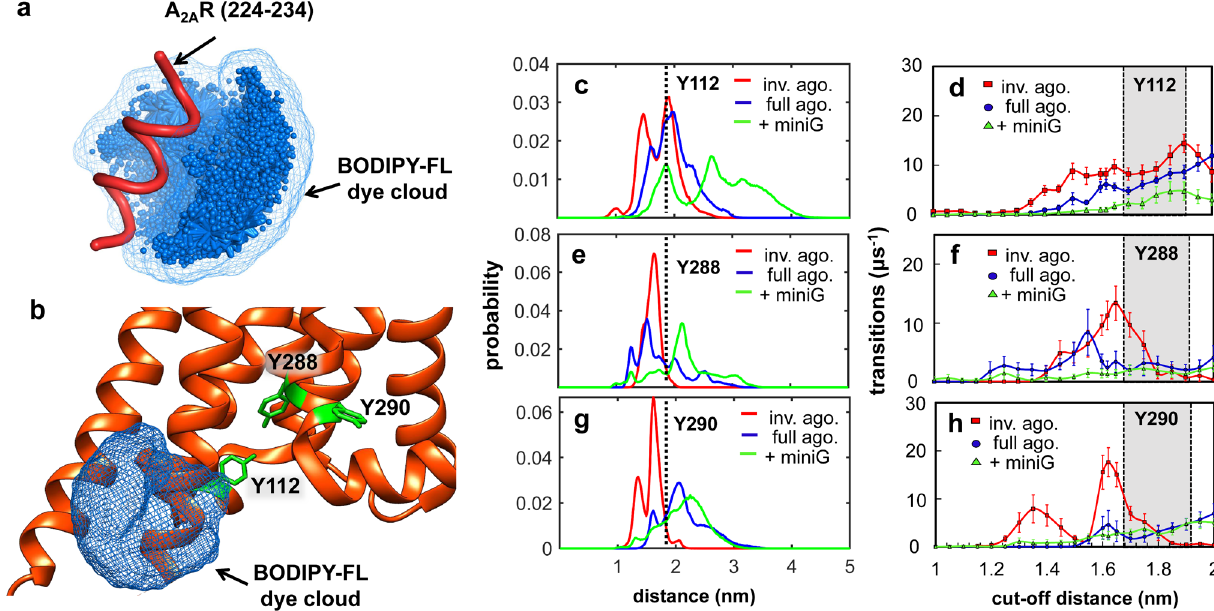
Figure 5. Molecular dynamics simulations of PET quenching dynamics in A 2A R. ( a ) Simulations of the cloud of possible positions of a BODIPY-FL molecule (with boron replaced by carbon) attached to position 229 6.31 within a small peptide segment of A 2A R (224–234). ( b ) The simulated BODIPY-FL cloud from ( a ) overlaid with the PDB structure of A 2A R, with tyrosine residues (green) in the proximity representing possible PET quenching candidates. Probability distributions for the distance between the beta-carbon of position 229 to the center of mass of the aromatic system of tyrosine Y112 on ICL2 ( c ), Y288 7.53 ( e ) and Y290 7.55 ( g ) on TM7: inverse agonist (red), full agonist (blue), full agonist + miniG (green). Inter-residue distance corresponding to the cut-off distance for PET quenching of BODIPY-FL by tyrosine, d q = 1.81 nm, is shown as a vertical dash line. The frequency of quenching/de-quenching transitions for Y112 ( d ), Y288 7.53 ( f ) and Y290 7.55 ( h ) as a function of cut-off distance in presence of inverse agonist (red squares), full agonist (blue circles), and full agonist + mini G (green triangles).Error bars are standard deviations from 6 replicate simulations. The shaded regions in ( d,f,h ) represent the most likely cut-off distance for PET quenching of BODIPY-FL by tyrosine, d q = 1.8 ± 0.1 nm. MD simulations were initiated using crystal structures in which the A 2A R was crystalized bound to an inverse agonist, an agonist, or an agonist plus mini-G, as shown in Table